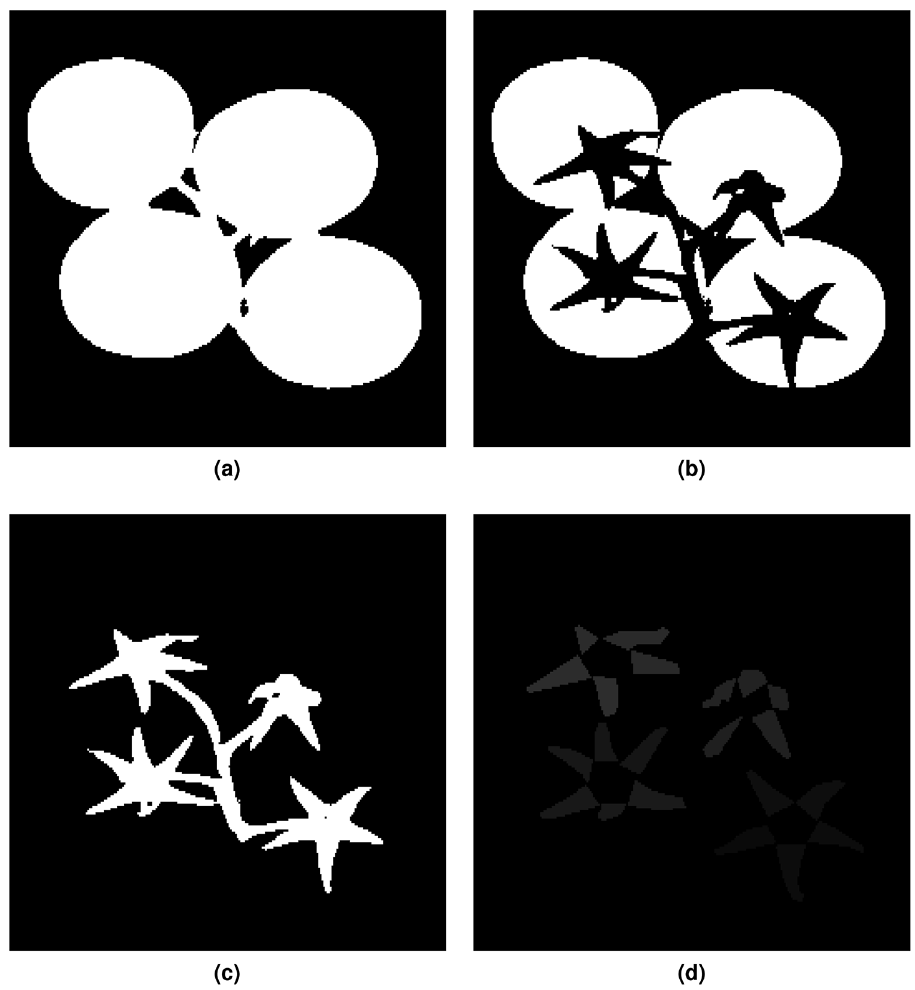
Figure 9. ( a ) Mask of the truss, ( b ) mask of the region belonging to tomatoes, ( c ) mask of the ROI (sepal region) and ( d ) sepal identification